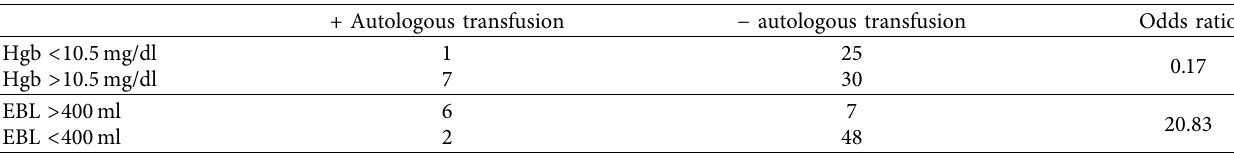
Table 6: Patients with preoperative hemoglobin less than 10.5mg/dl were 5 times less likely to receive autologous blood transfusion compared to patients with hemoglobin > 10.5mg/dl. Autologous transfusion was also 20 times more likely when blood loss exceeded 400ml. + Autologous transfusion − autologous